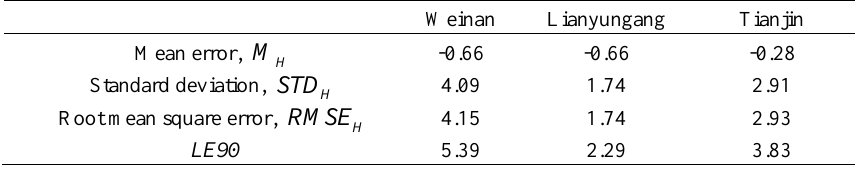
Table 3. Statistical results for the elevation differences in the three experimental regions.